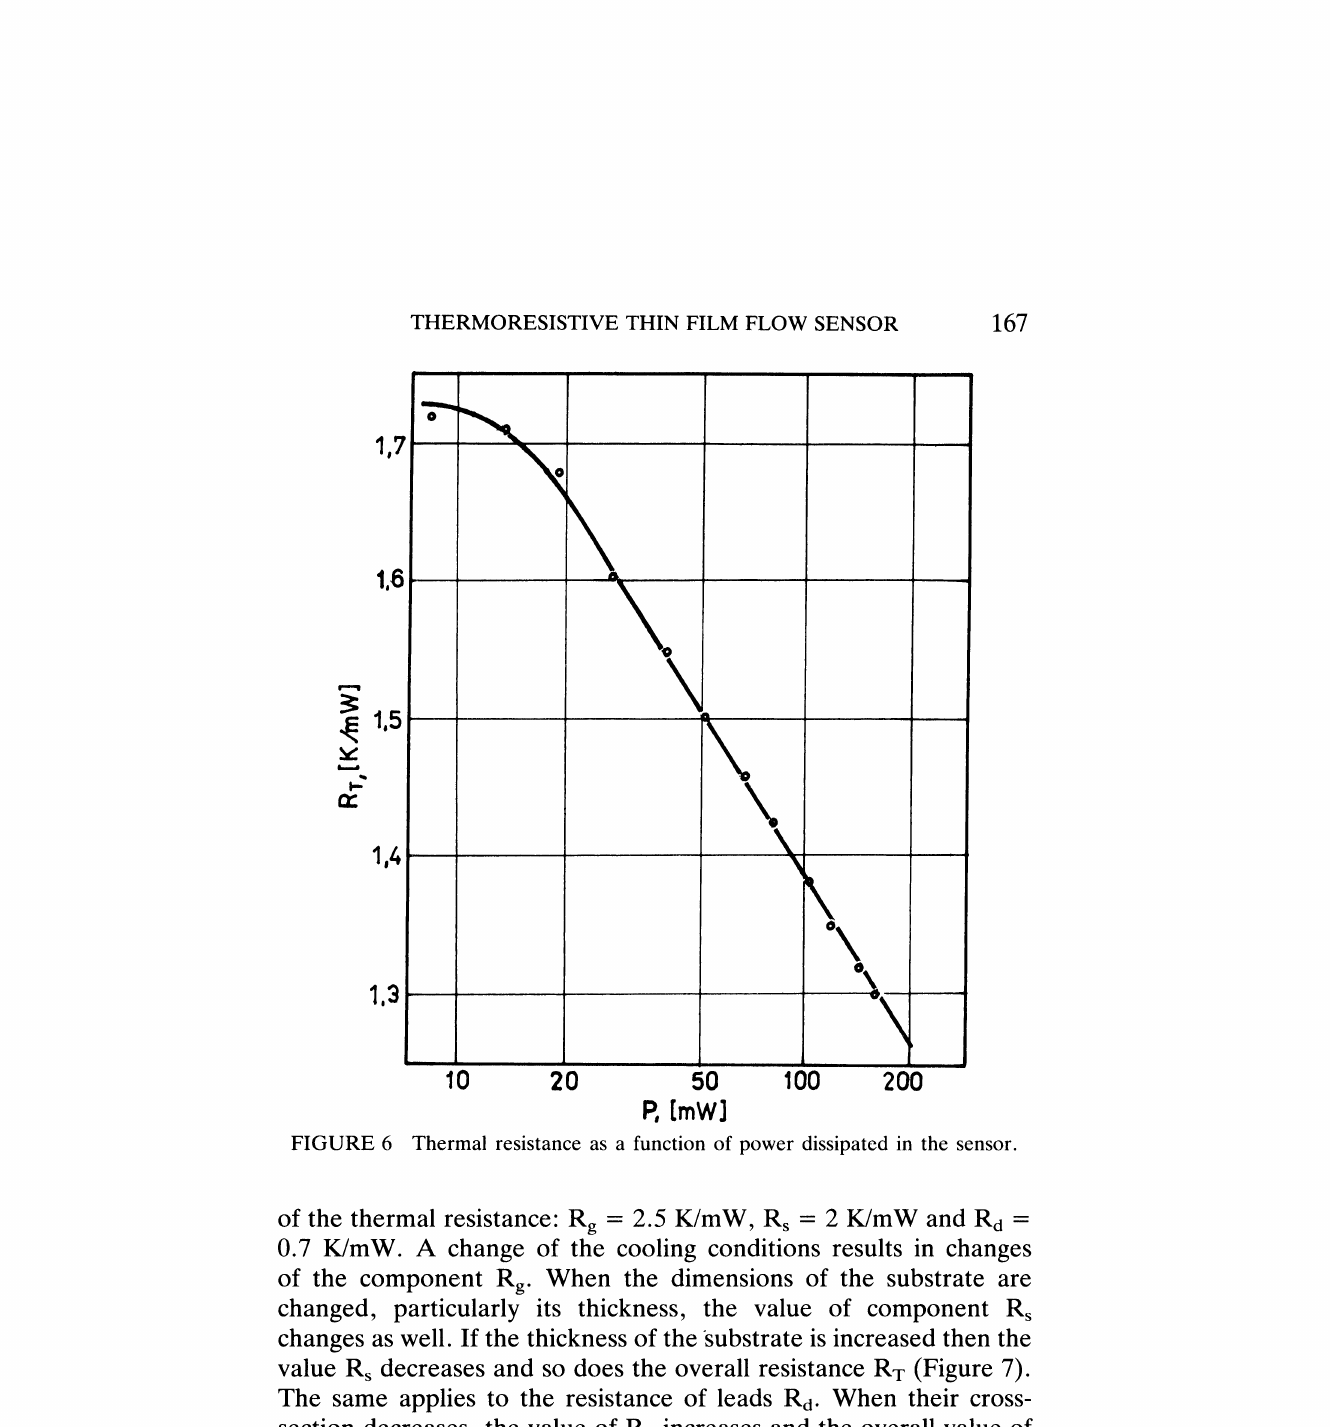
FIGURE 6 Thermal resistance as a function of power dissipated in the sensor. of the thermal resistance" Rg 2.5 K/mW, Rs 2 K/mW and